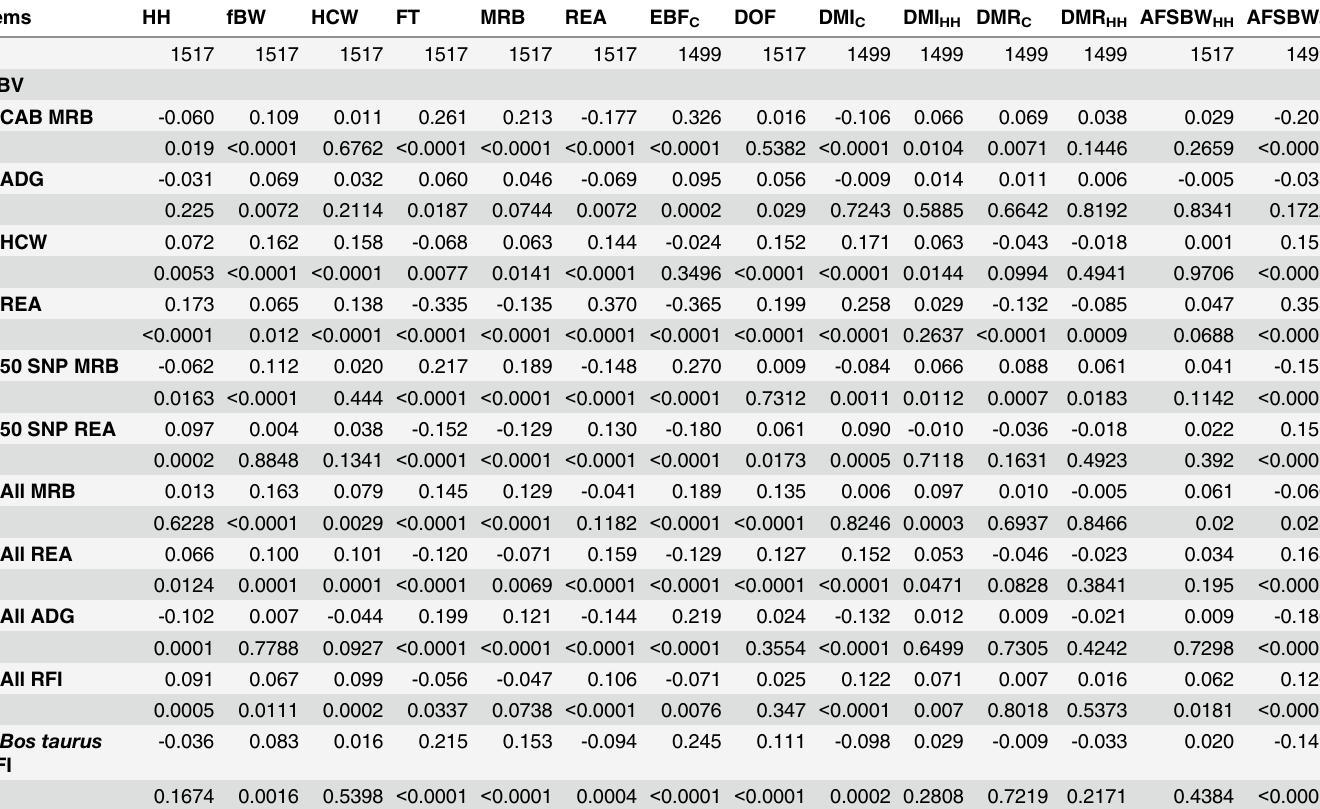
Table 2. Correlation matrix between molecular breeding value (MBV) scores and selected model input and output variables 1 .